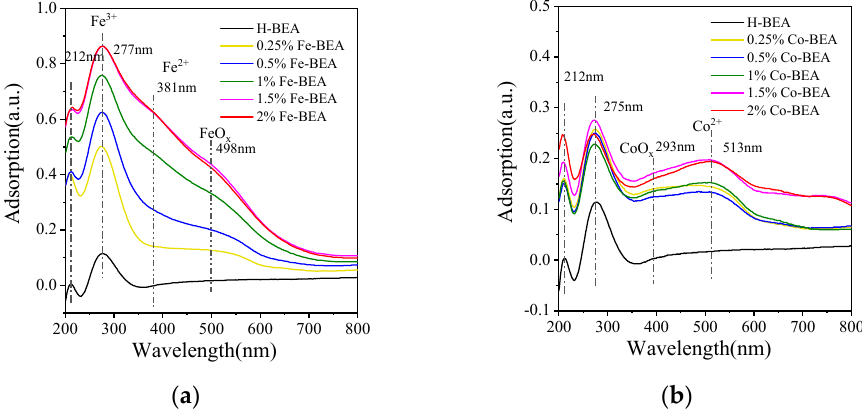
Figure 4. ( a ) UV − vis diffuse reflectance spectra of Fe-BEA with different concentrations; ( b ) UV − vis diffuse reflectance spectra of Co-BEA with different concentrations.